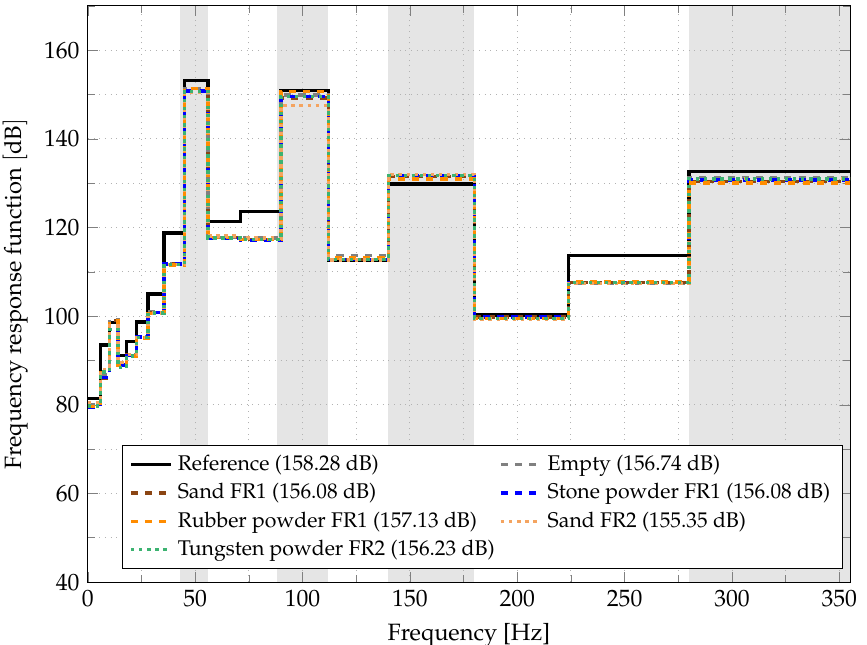
Figure A10. One-third octave band representation of FRF of WTS test specimen. SU HCDP mounted to the inner wall of stator ring (excitation point side). SL value of surface velocity is given in dB.